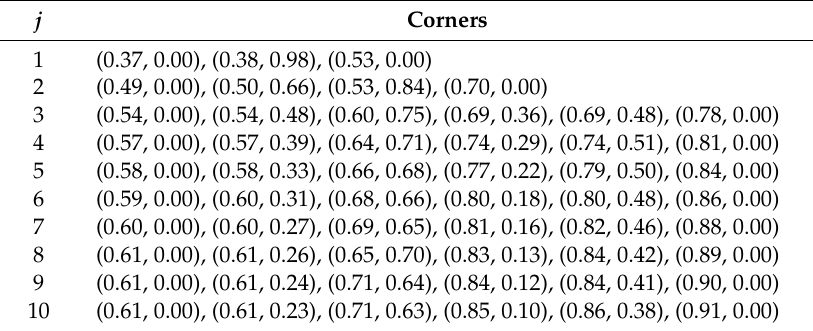
Table 3. Aggregation result